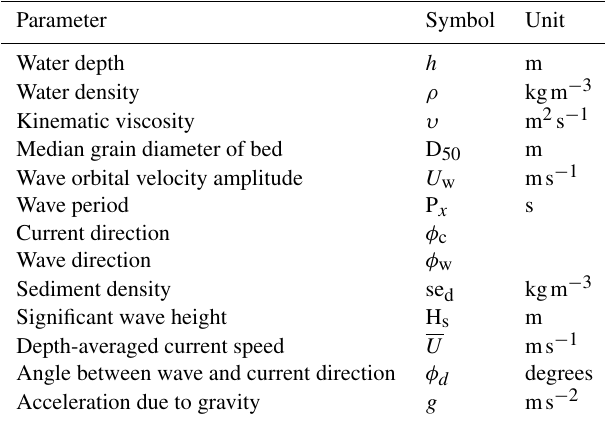
Table A1. Calculation inputs.